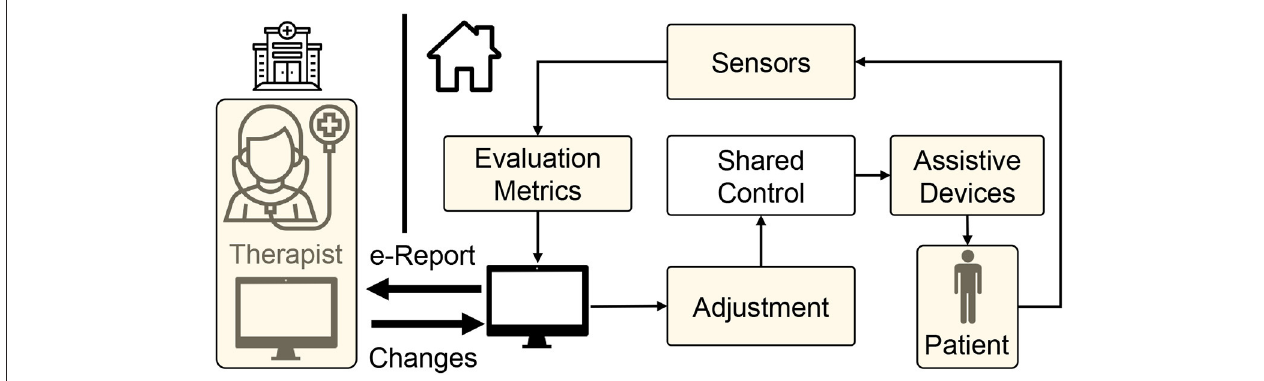
FIGURE 1 | Schematic of tele-rehabilitation where patients can continue their rehabilitation with the help of an assistive device while therapist can monitor the progress